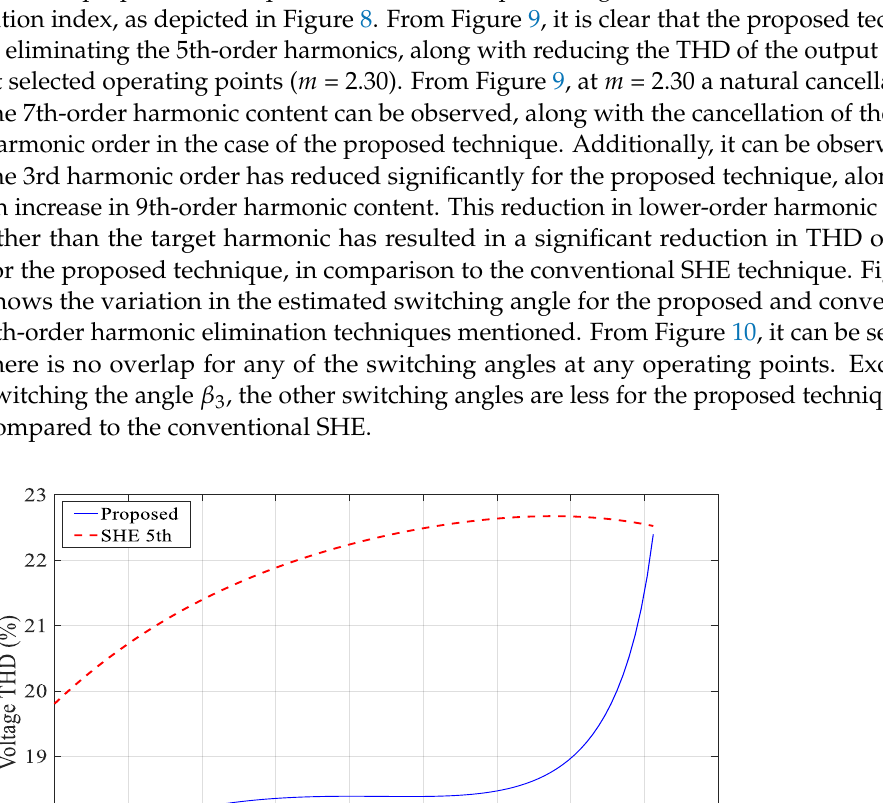
Figure 7. Curve showing variation between the estimated switching angles and modulation index for SHE of 3rd-order harmonics and the proposed technique.